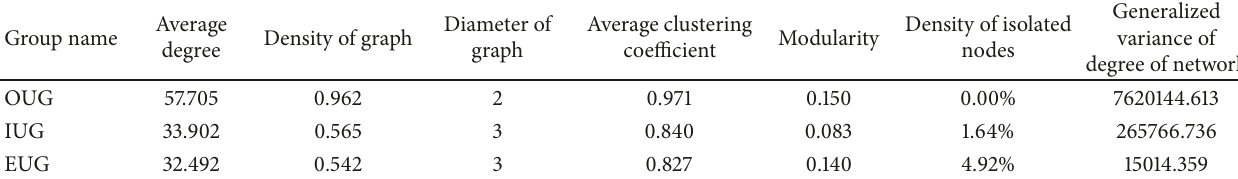
Table 3: Statistical results of three networks.